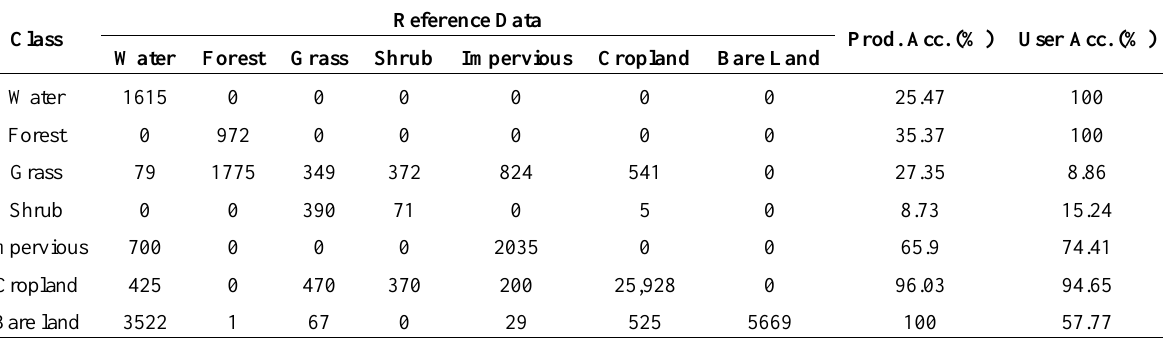
Table 2. Accuracy evaluations of Finer Resolution Observation and Monitoring of Global Land Cover (FROM–GLC) data in